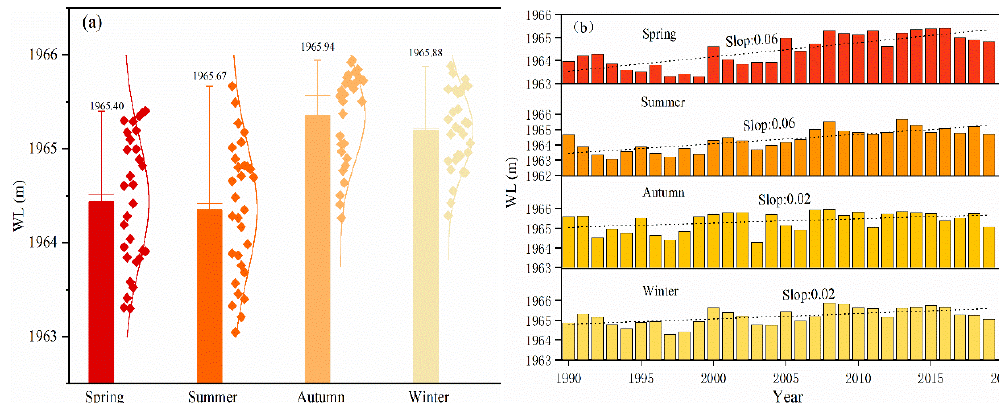
Figure 8. Seasonal ( a ) and interannual ( b ) variations in the water level in Erhai Lake. The standard seasonal division is as follows: spring is from March to May, summer is from June to August, autumn is from September to November, and winter is from December to February.